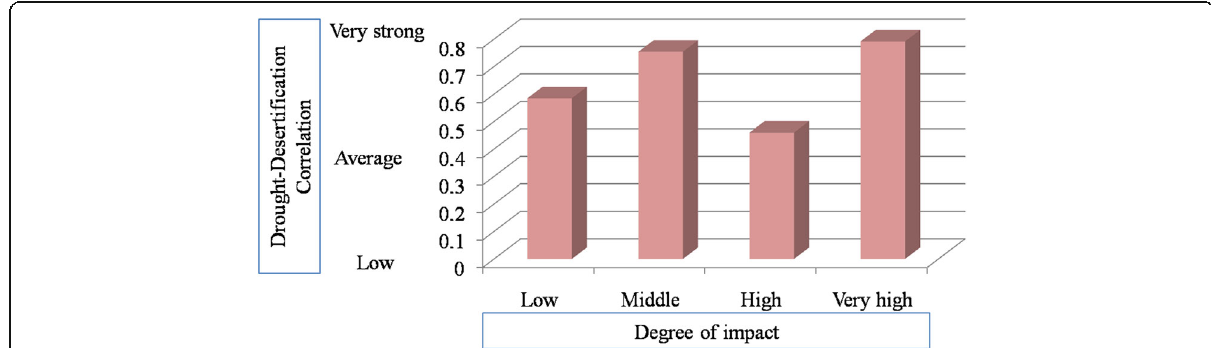
Fig. 7 Pearson Correlation between desertification and drought for the 17 variables, with n =17; significance (a=0.05), Degree of Liberty: 15. Interpretation from left to right: Average correlation Strong correlation Average correlation Very Strong